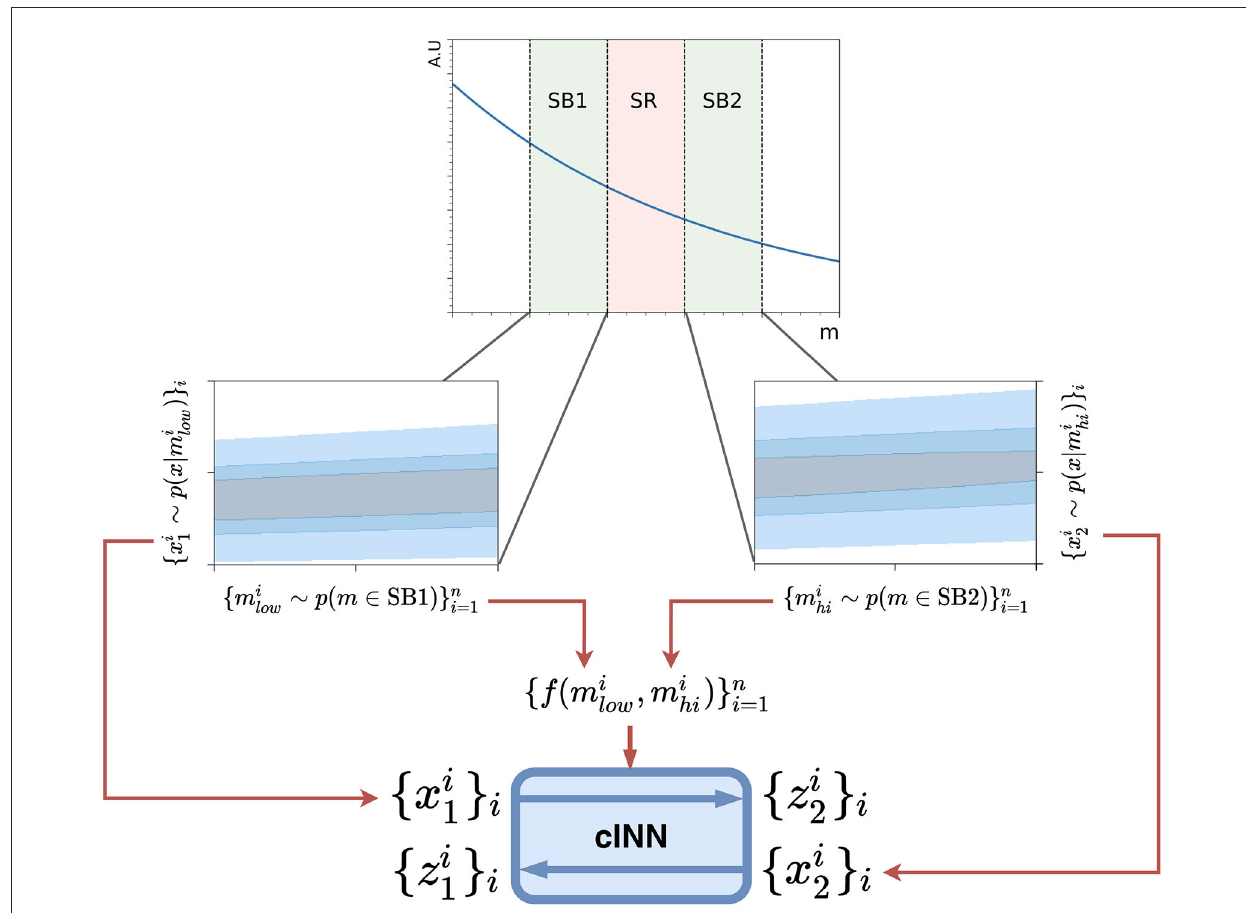
FIGURE1 A schematic overview of the C URTAIN s model. A feature x is correlated with m , as can be seen from the 2D contour plots for each side-band in blue. n 2 n Samples x 1 i i = 1 and { x i } i = 1 of batch size n are drawn randomly from the two side-bands. In the forward pass the samples from SB1, { x 1 } { } passed through the conditional INN where each sample x i 1 is conditioned on f the distance between this output and the sample from SB2 model, any value for m can be chosen as long as the correct inverse or forward pass is